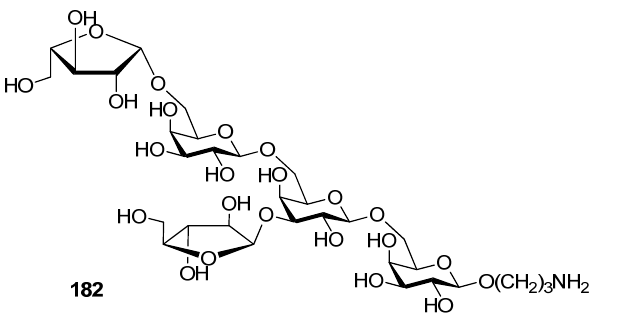
Figure 7. A fragment of arabinogalactans in the primary plant cell